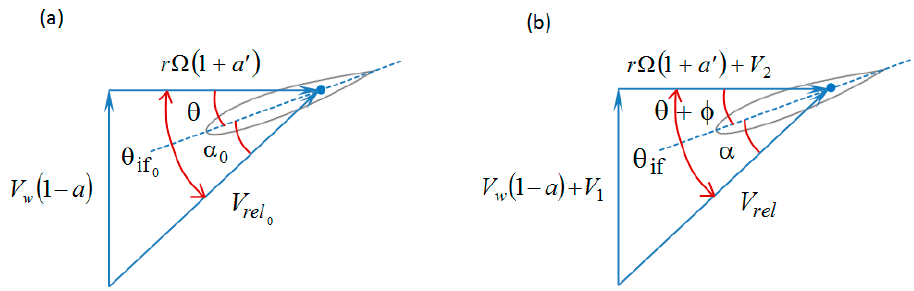
Figure 3. Velocity triangle at the blade section ( a ) without and ( b ) with blade vibrations.